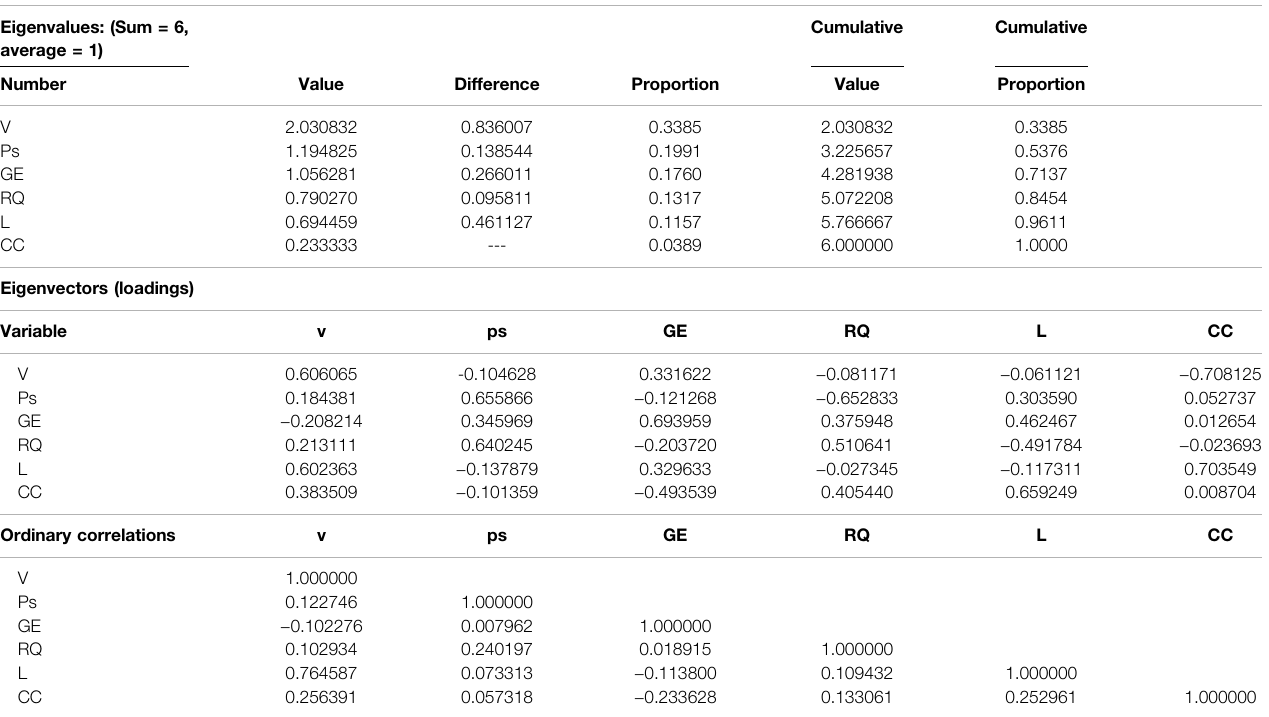
TABLE 2 | Principal components